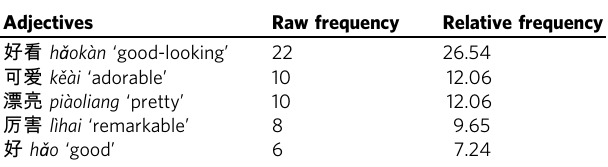
Table 10 Most frequent adjectives in girls ’ imitated masculine